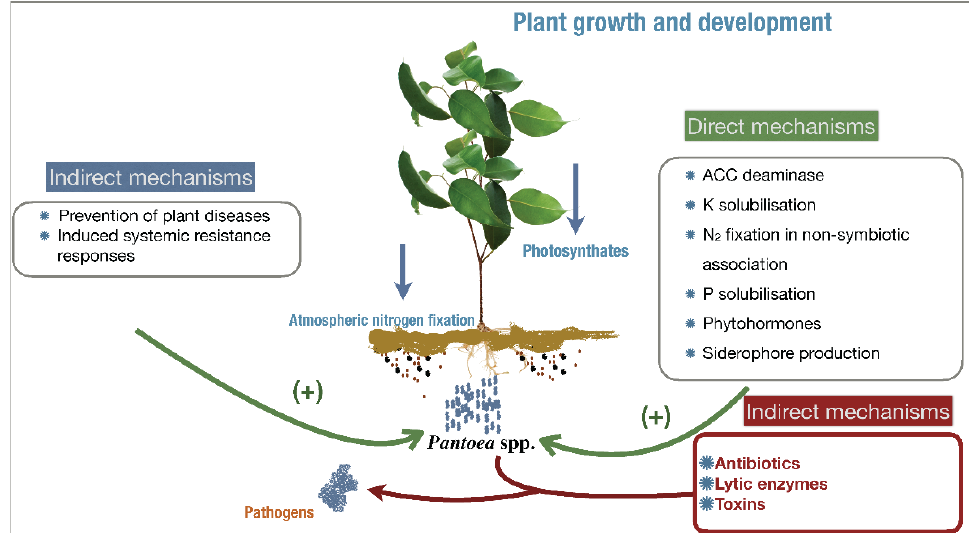
Figure 1. Direct and indirect mechanisms for plant growth by Pantoea agglomerans . ACC: 1-aminocyclopropane-1-carboxylate deaminase.